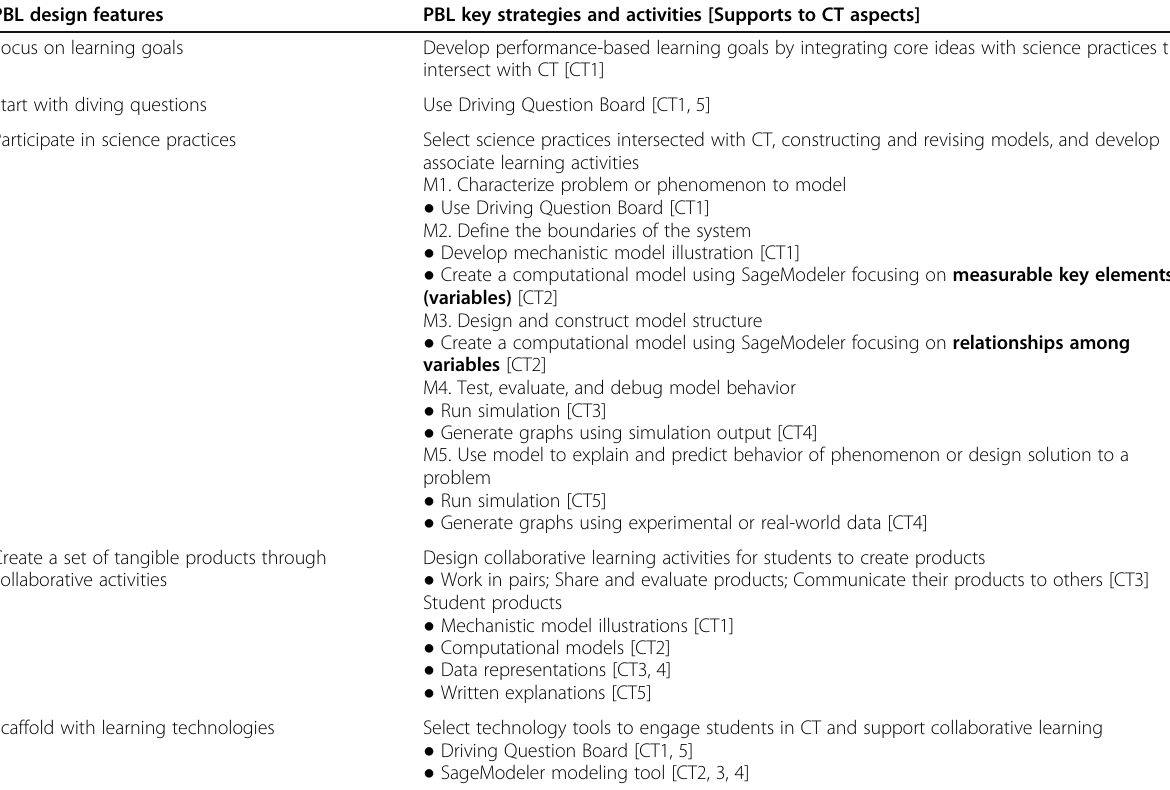
Table 1 PBL design features, PBL strategies/activities, and associated teacher and student supports to CT PBL design